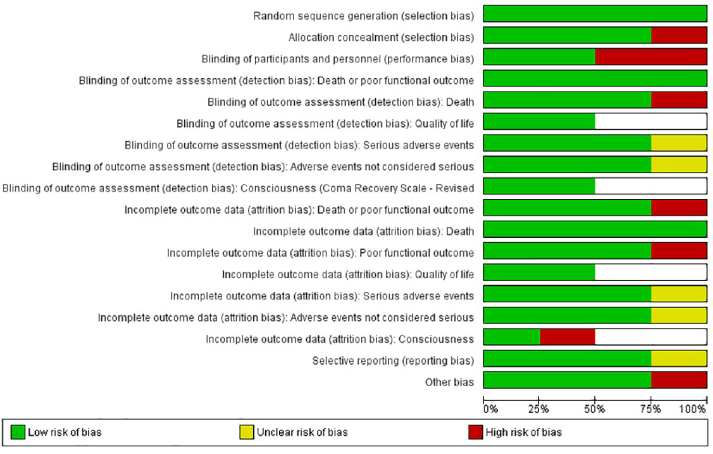
Fig 3. Risk of bias graph: Review author’s judgements about each risk of bias item presented as percentages across all included studies.